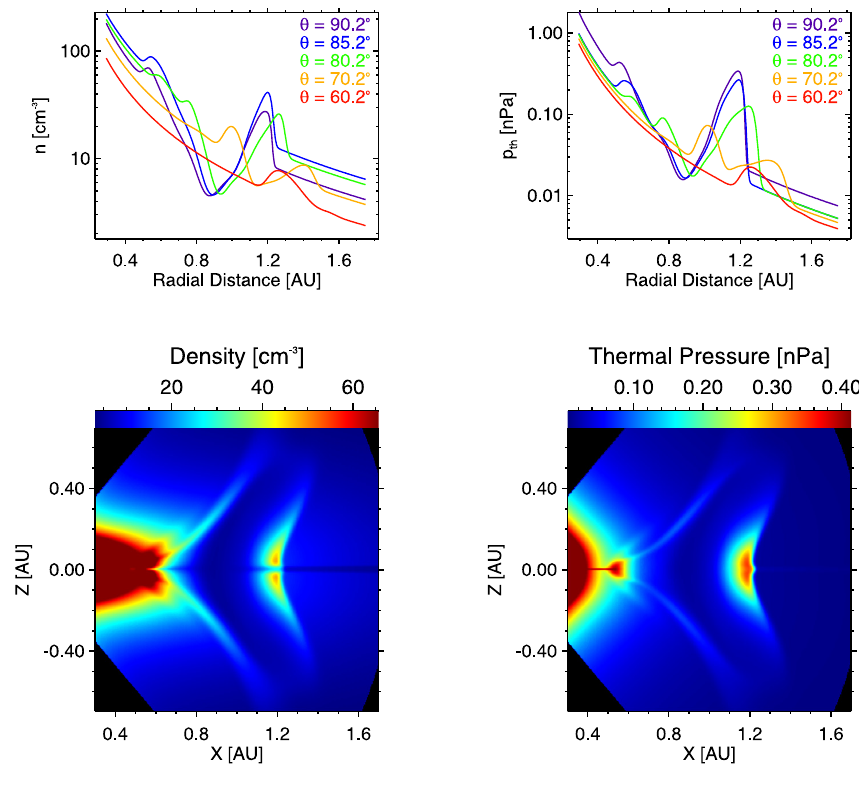
Fig. 13. Density (left) and thermal pressure (right) for the H + m magnetic cloud near